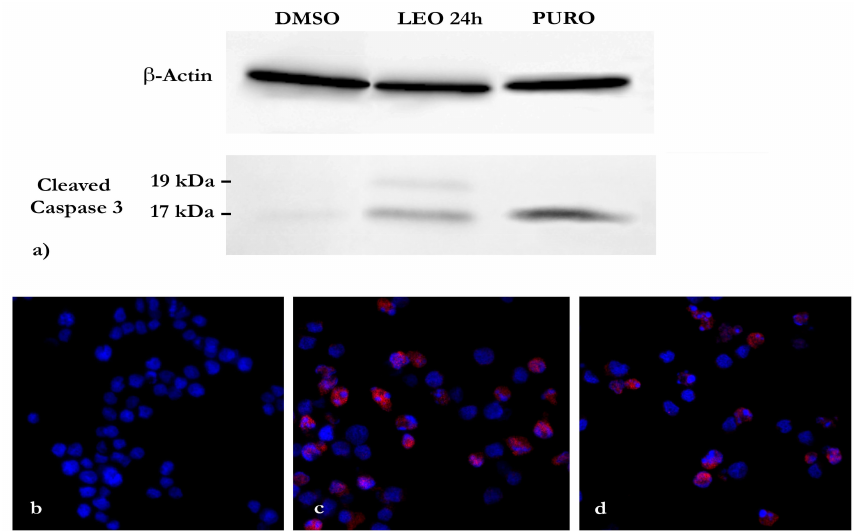
Figure 3. Cleaved caspase-3 expression investigated by Western blotting and immunofluorescence analysis using a cleaved caspase-3 monoclonal antibody. ( a ) Western blotting analysis. In the lower panel, cleaved capese-3 detection in DMSO, LEO, and puromycin treated HL60 cells; in the upper panel, β -actin detection as the internal control; ( b ) immunofluorescence analysis in the confocal microscopy of DMSO treated HL60 cells, ( c ) LEO treated HL60 cells, and ( d ) HL60 puromycin treated HL60 cells.